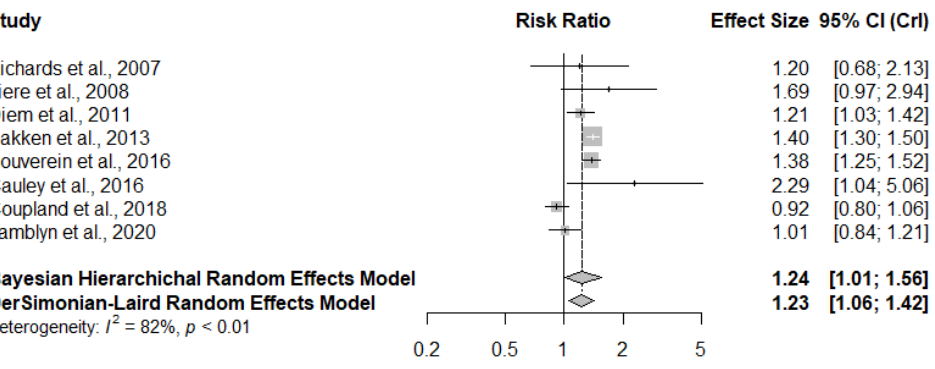
Figure 2. Fracture risk associated with tricyclic antidepressants use for individual studies, and all eligible studies combined by using frequentist and Bayesian approaches. (CI, confidence interval; CrI, Credit Interval).